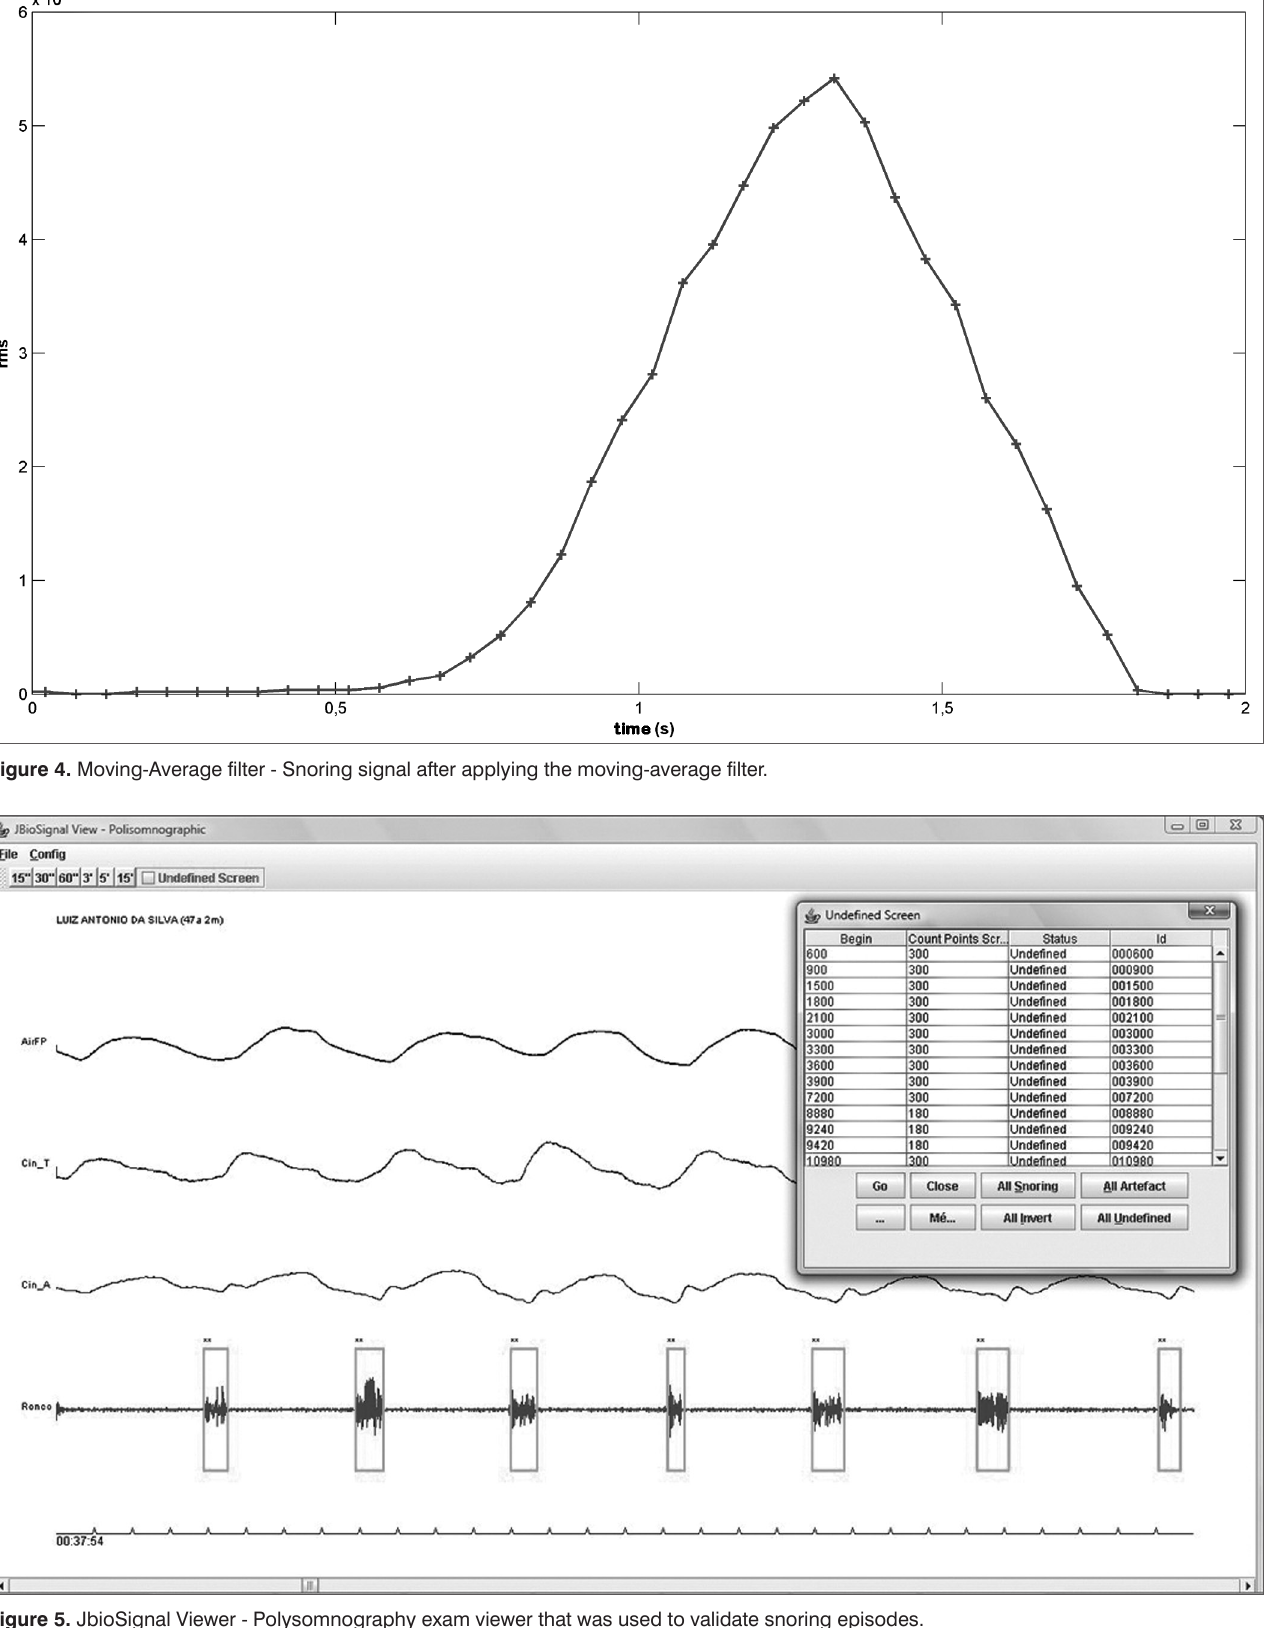
Figure 5. JbioSignal Viewer - Polysomnography exam viewer that was used to validate snoring